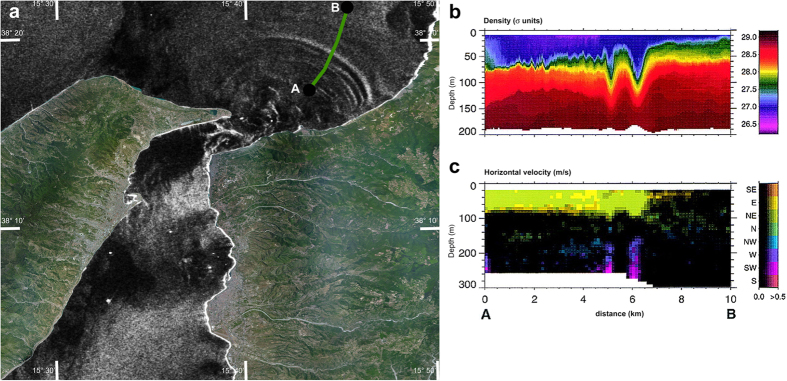
ISW in the Messina Strait.(a) COSMO-SkyMed SAR image showing the sea surface manifestations of a train of ISWs propagating northward into the Tyrrhenian Sea (map generated by CARIS Easy View 4.1 http://www.caris.com/products/easy-view). The green line indicates the transect in (b,c). (b) Density distribution measured by Brandt et al. [1999] with a CTD chain between the positions A and B in (a). (c) Horizontal velocity field measured by Brandt et al. [1999] with the ADCP. Colors represent the different directions of the horizontal velocity, whereas their brightness represents the velocity magnitude. Note the two velocity peaks at the sea bottom right below the ISWs trough. Panels (b,c) are modified and republished with permission of the American Meteorological Society, from “Evidence for the influence of Atlantic-Ionian stream fluctuations on the tidally induced internal dynamics in the Strait of Messina”, Brandt et al., 29(5), 1999; permission conveyed through Copyright Clearance Center, Inc.